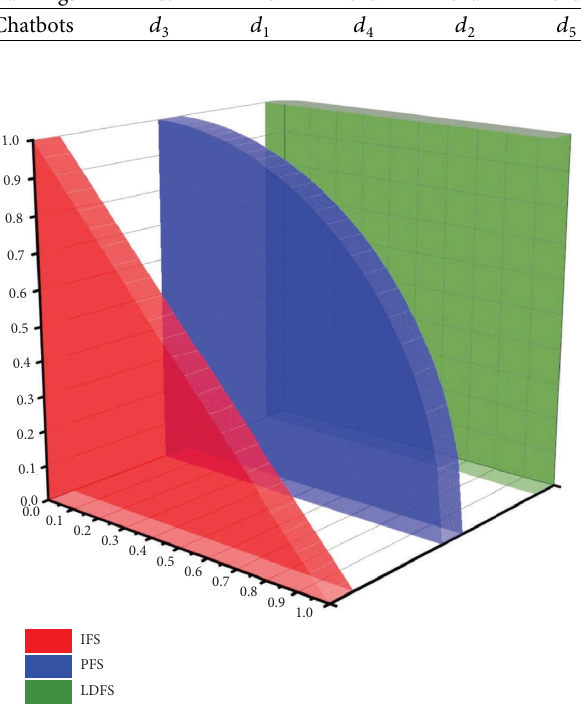
Figure 6: Space comparison of IFS, PFS, and LDFS. Table 18: Ranking comparison with the optimal choice of bridge designs.